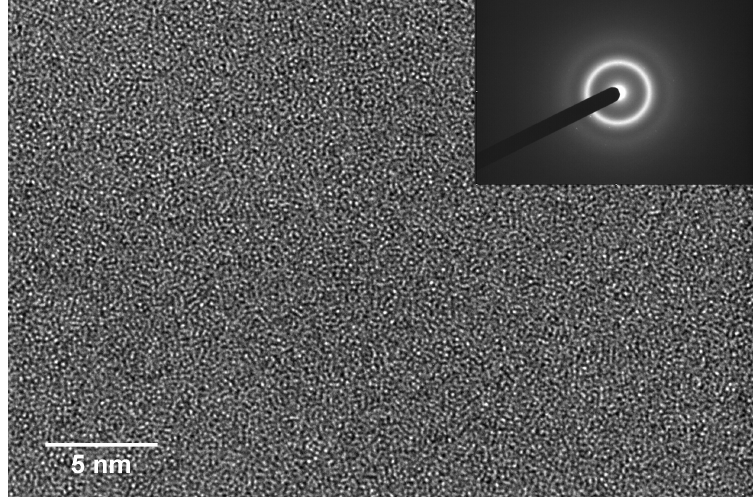
Figure 5. In the high resolution TEM image no ordered regions can be detected. The inset shows a diffraction pattern at the same position but from a much larger region (selected area diffraction (SAD) aperture size: 120 µm). The broad rings confirm the amorphous state of the specimen.